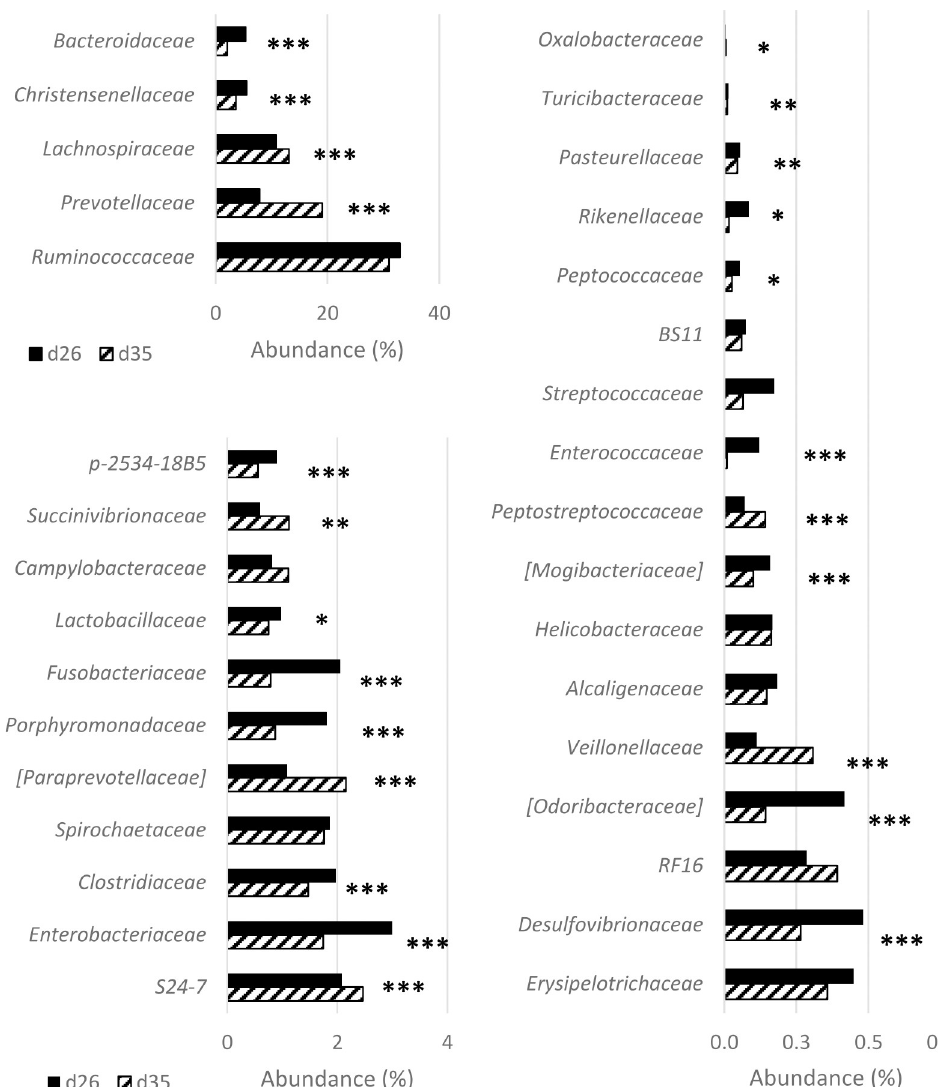
Fig 2. Relative abundances of the 33 families detected in piglet fecal samples before and after weaning. Samples were collected from suckling 26-day-old (n = 222) and weaned 35-day-old piglets (n = 254) from 16 commercial farms. For each taxon a significant effect of age is indicated by ��� (P < 0.001) �� (P < 0.01) or � (P <